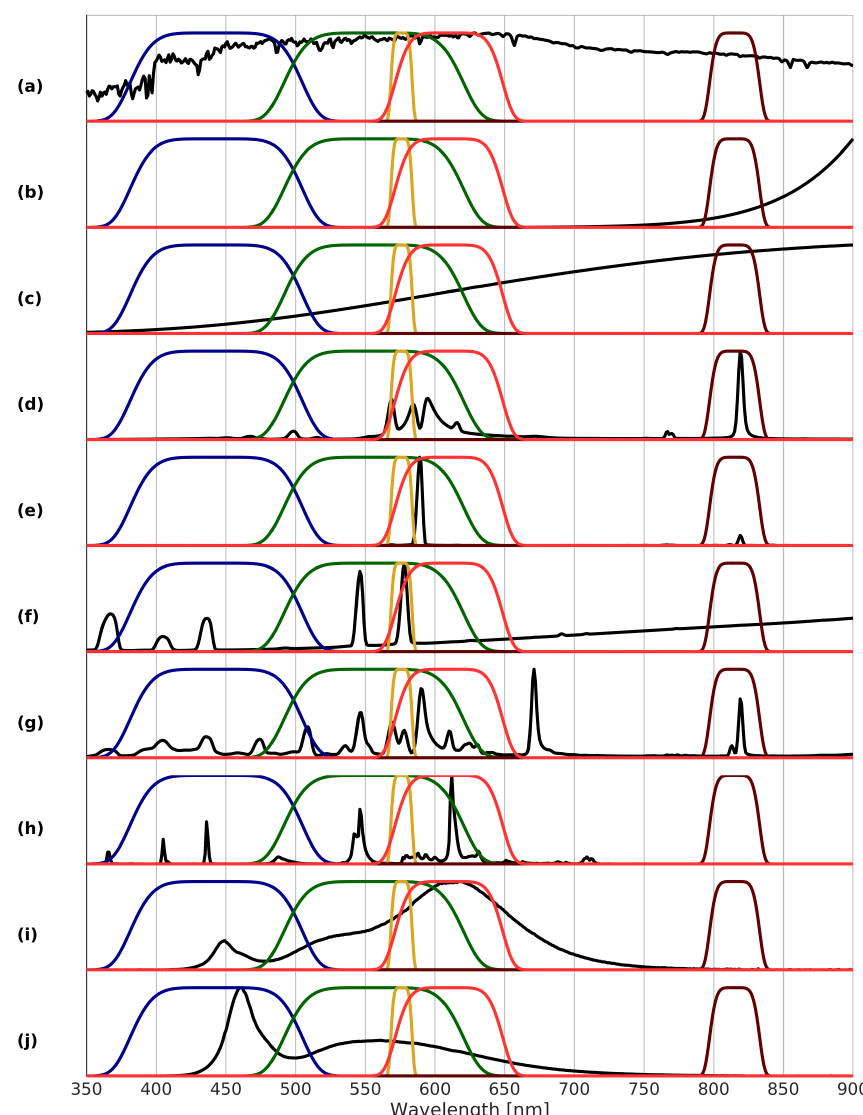
Figure 5. Selected bands and typical normalized emission spectra by NOAA [17] and GUAIX [20] for different nighttime radiation sources (stacked offset for clarity): Band 1 (green, 493–619nm); Band 2 (blue, 383–503nm); Band 3 (yellow-orange, 568–584nm); Band 4 (near infrared, 797–833nm); Band 5 (red, 572–648nm). Note that Band 0 (panchromatic, 374–864nm) is not plotted. ( a ) cloud-free full moon; ( b ) fire, 700K; ( c ) incandescent lamp; ( d ) high-pressure sodium lamp; ( e ) low-pressure sodium lamp; ( f ) mercury vapor lamp; ( g ) metal halide lamp; ( h ) fluorescent lamp; ( i ) warm-white LED lamp; ( j ) cold-white LED